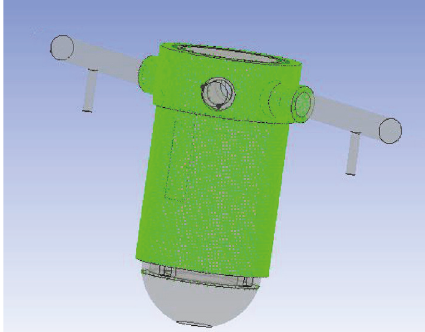
Figure 8: The grid of RPV.